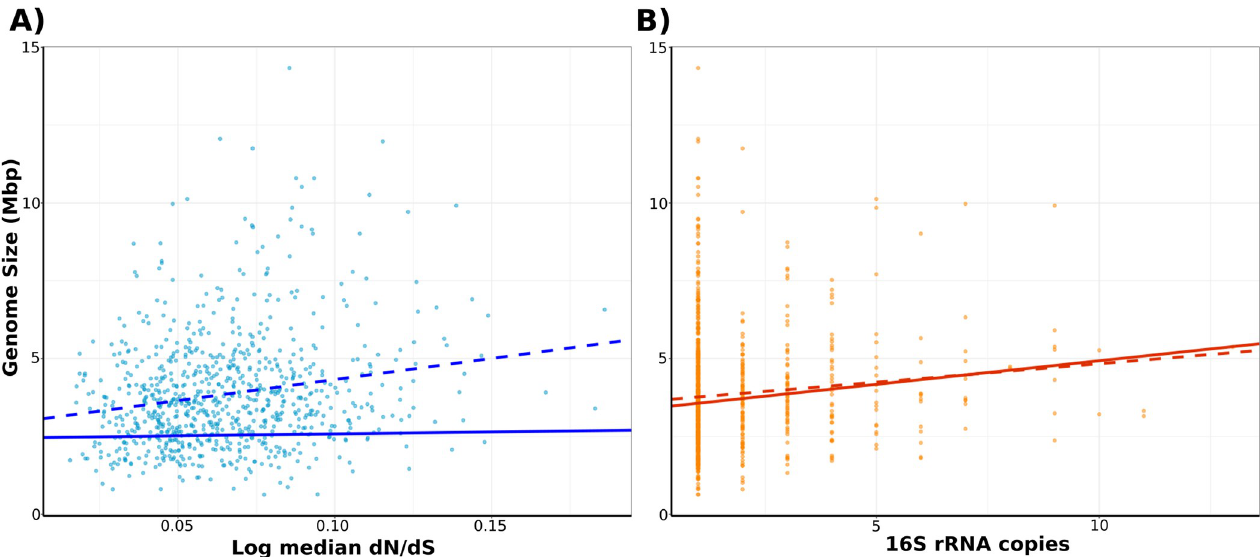
Fig 3. Relationship between genome size and genomic traits for bacteria and archaea using one representative genome for each genus. A) Regression line of the relationship between genome size and dN/dS ratio before (dashed line) and after (solid line) taking phylogenetic relationships into account through the Pagel’s model. B) Regression line of the relationship between genome size and 16S rRNA copies before (dashed line) and after (solid line) taking phylogenetic relationships into account through the Brownian Motion model. Parameters of the regression equation for both relationships can be found in Table 2. Raw data can be found in S2